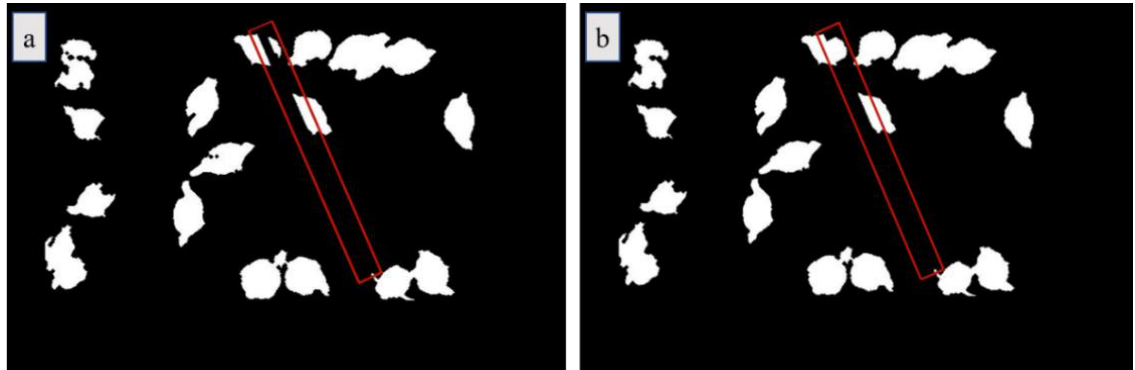
Figure 6. Occlusion area restoration for TA: ( a ) removed pipe and its surrounding area; ( b ) restored pipe area and chickens’ images.